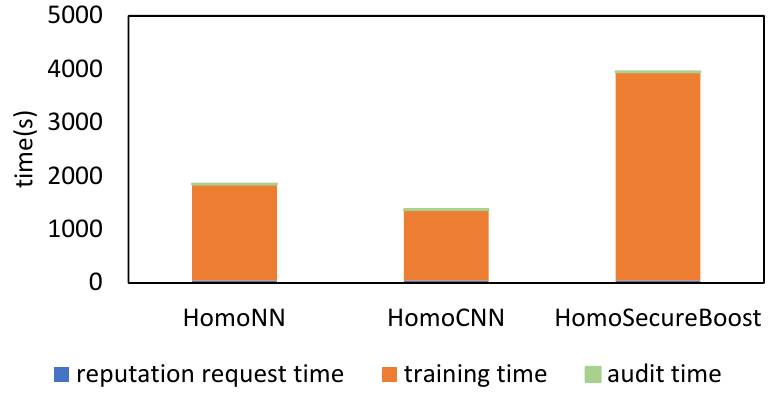
Figure 15. Comparison of the time cost of different models.